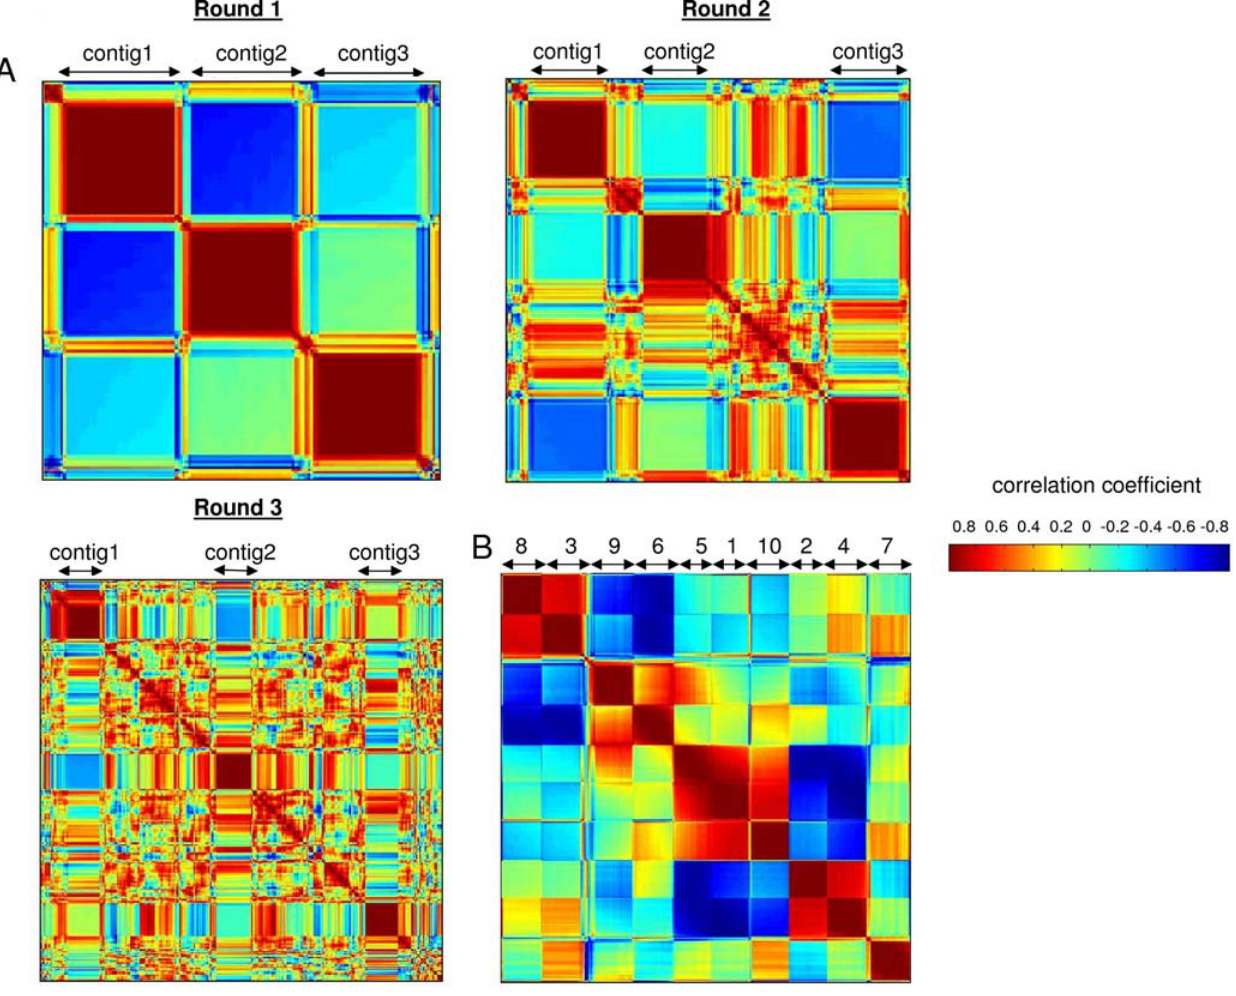
Figure 1. Performance of seriation on simulated SAGE data. (A). Seriation results of the three rounds of simulations with increasing amounts of noise from round 1 (34 tags) to round 3 (384 tags). The dark red squares along the diagonal indicate tags with the expression patterns 1–3 that were grouped together by seriation. (B). Seriation of 10 expression profiles with limited amount of noise. The dark red squares along the diagonal indicate tags in each expression profile that were grouped together. The numbers indicate expression patterns from Figure S1 that were grouped into each contig. Note that two contigs in the middle (5 and 1) appear more similar to each other than any other contig pair indicating similarity of the corresponding expression